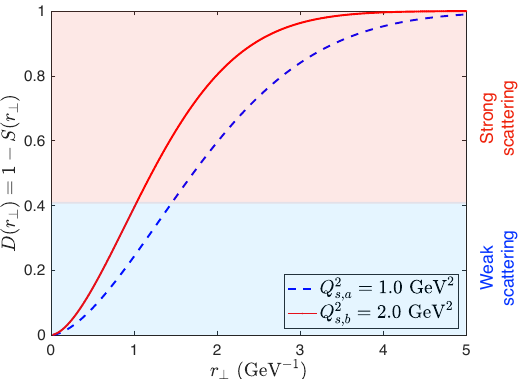
) = 1 ) in the MV model (see Equation(11)) with two S ( 2 ) ( r − ⊥ ⊥